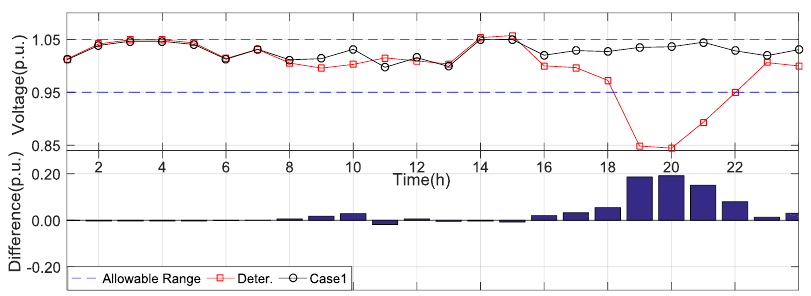
Figure 8. Voltage profile of critical nodes in different cases.